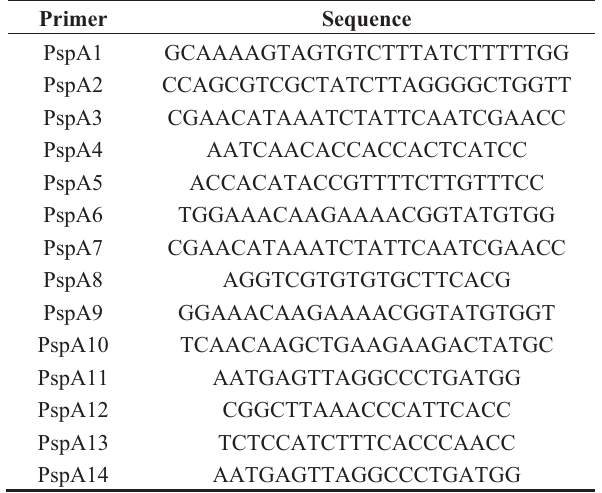
Figure A1. The amino acid sequence of the fusion protein (rPspA), comprising the PRR of PspA linked to thioredoxin (Trx). The PRR is bold and underlined. Table A1. PCR primers used for sequencing pspA from clinical isolates (see Table